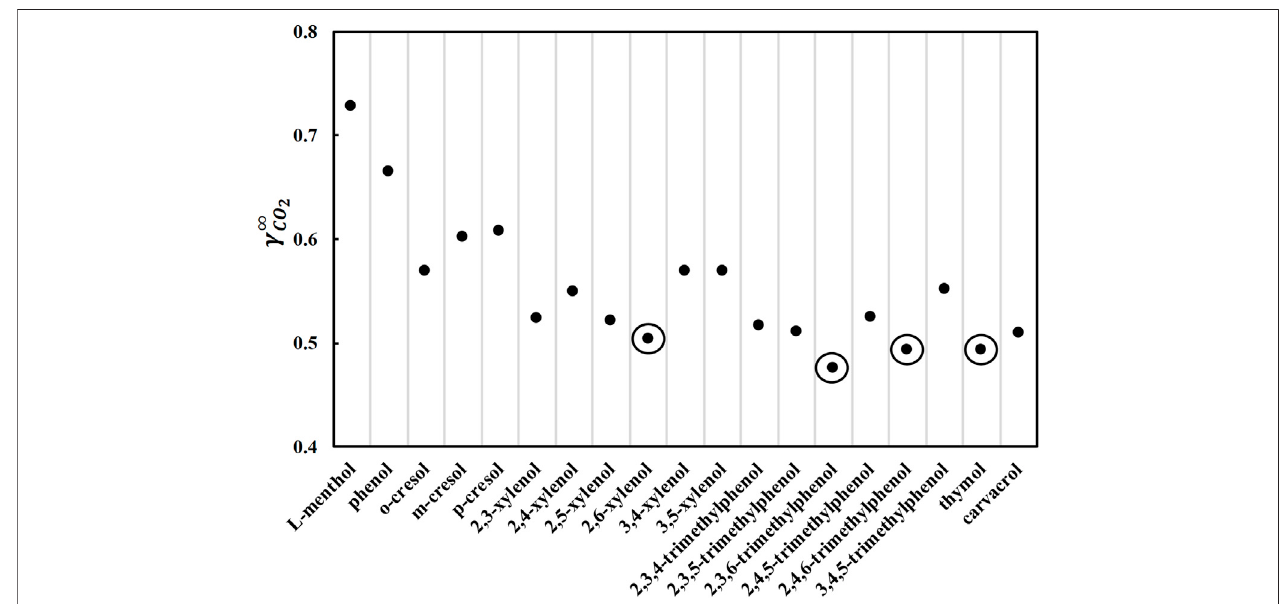
FIGURE 1 | Activity coef fi cients at in fi nite dilution of carbon dioxide in pure L-menthol and various phenolic alcohols at 293.15 K calculated by COSMO-RS.